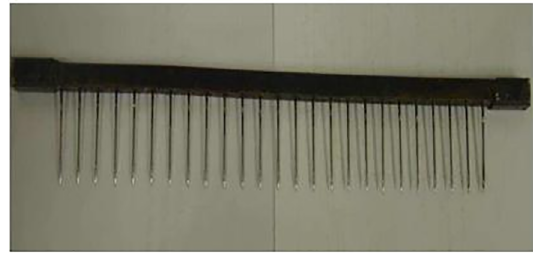
Figure 6. Multiple needles set up for stitching.